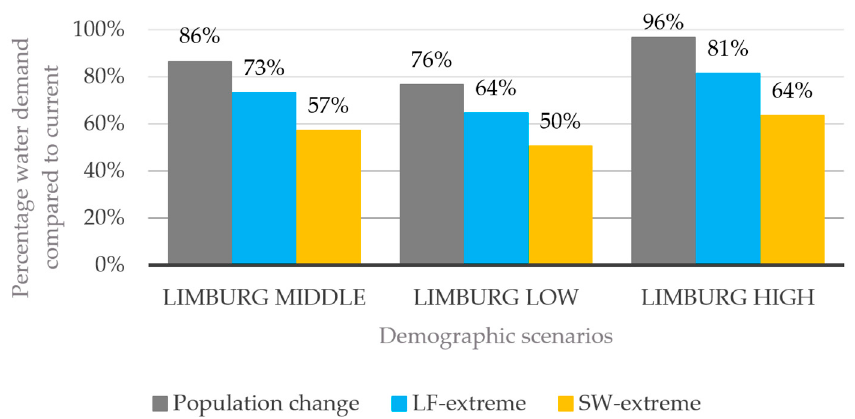
Figure 5. Change in total water demand in relation to the current demand (100%) in Limburg.